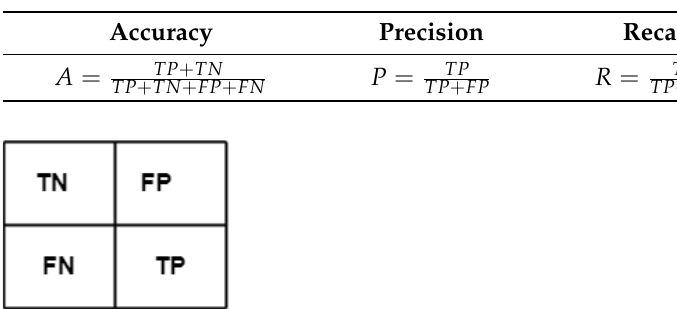
Table 4. The evaluation metrics.